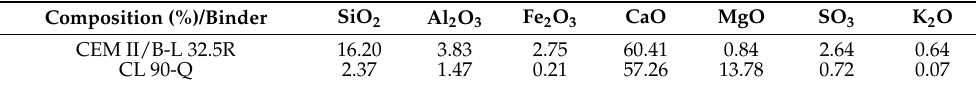
Figure 4. XRD of sandy soil.